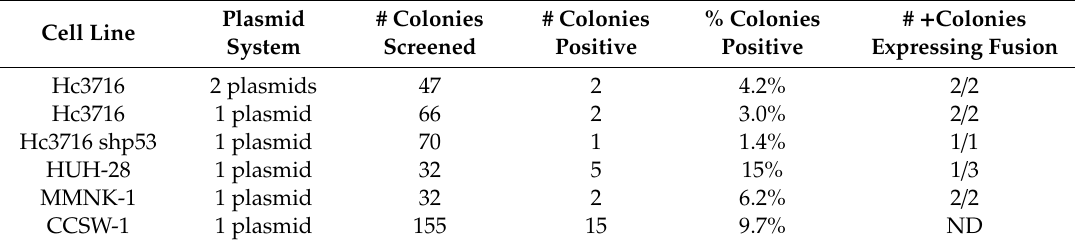
Table 1. FGFR2–BICC1 Fusion E ffi ciency.